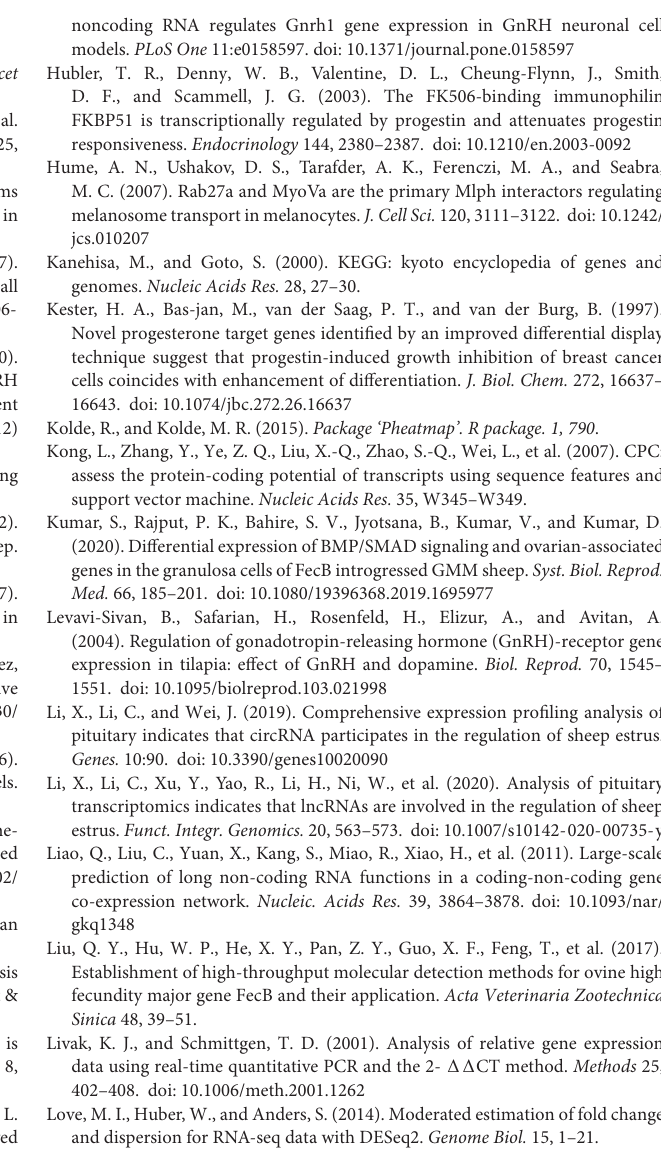
Supplementary Table 1 | Alignment of statistical results of reads. Supplementary Table 2 | The results of differentially expressed mRNAs. Supplementary Table 3 | The results of differentially expressed lncRNAs. Supplementary Table 4 | DEG GO and KEGG enrichment analysis. Supplementary Table 5 | Target genes of DEL GO and KEGG enrichment analysis. Supplementary Table 6 | The lncRNA-mRNA network.